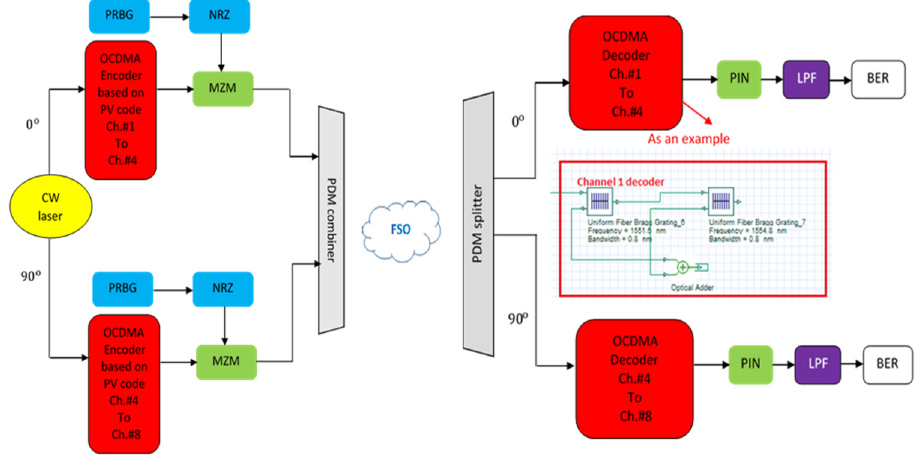
Figure 1. Schematic diagram of FSO-PDM/PV-OCDMA system. Table 1. Channels with their corresponding wavelengths.